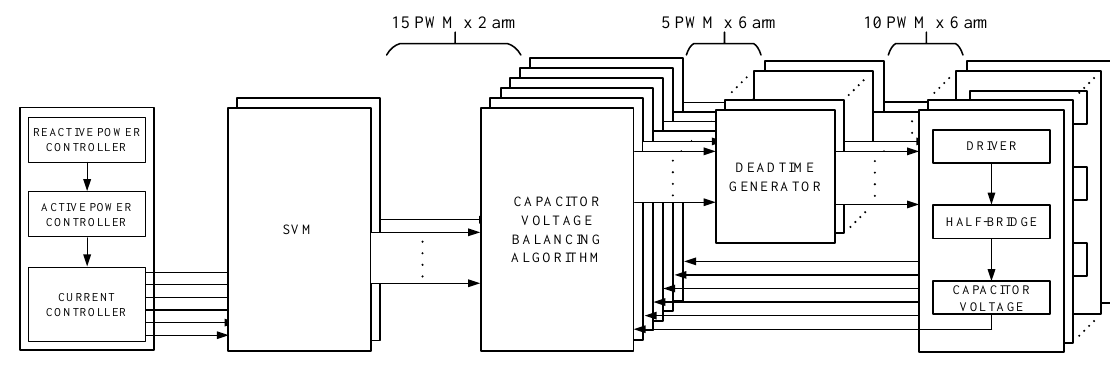
Figure 19. SVM full control diagram.